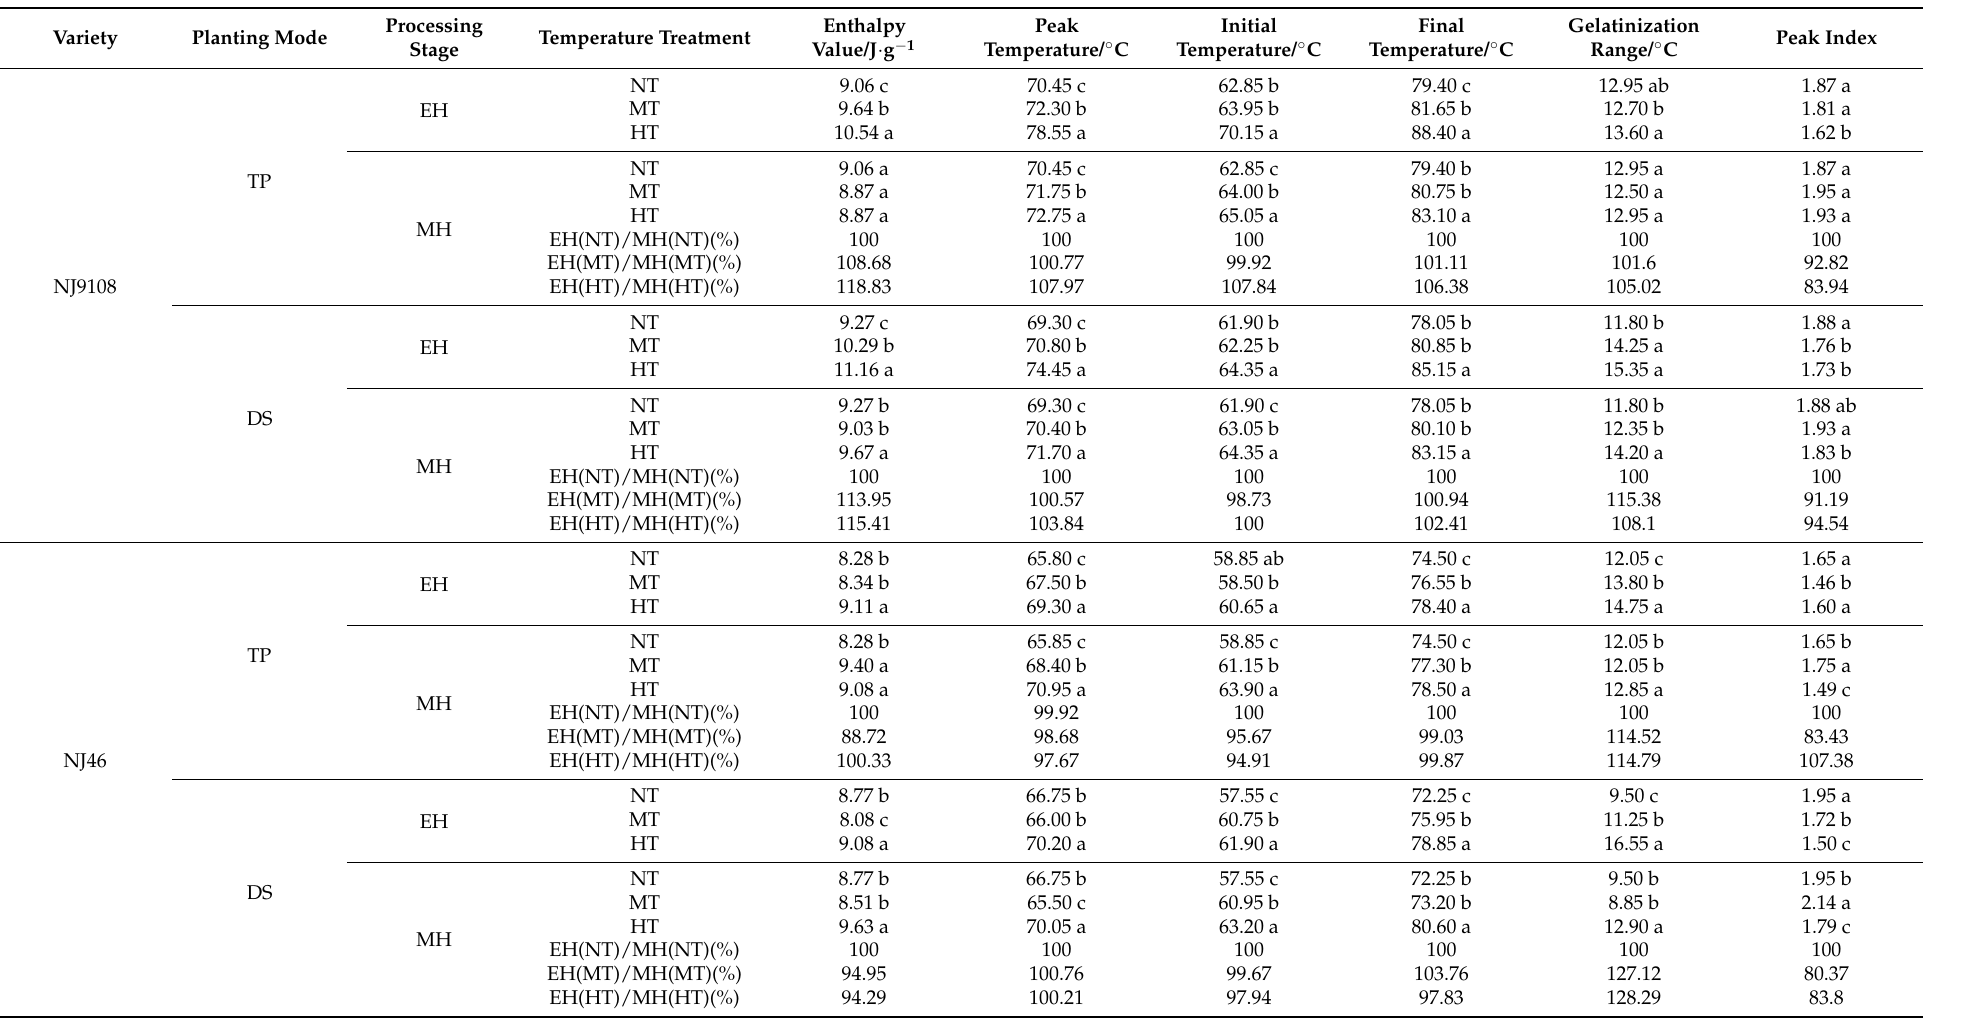
Table 8. Effects of high temperature on DSC of japonica rice in early and middle heading stage under transplanting and direct seeding.